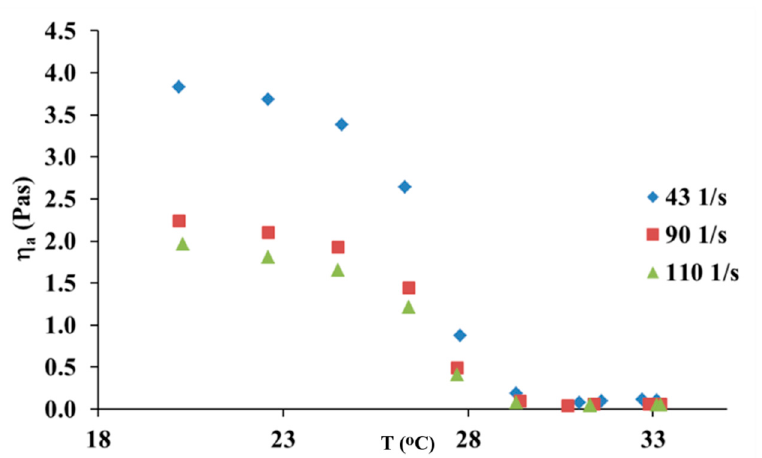
Figure 5. Apparent shear viscosity versus temperature for 10 mg / mL collagen solution at three di ff erent